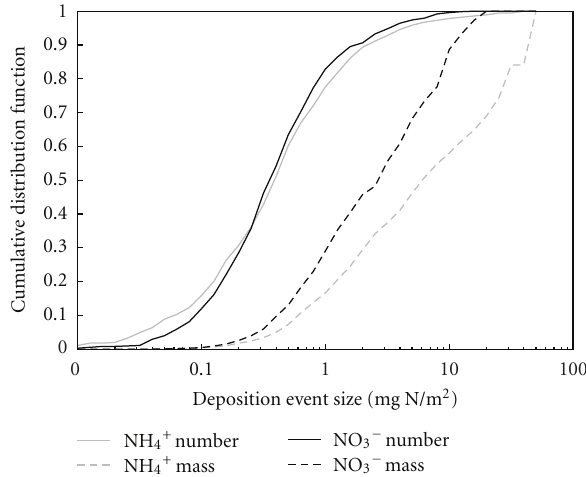
Figure 4: Cumulative distribution function of number and mass distributions for nitrate and ammonium. Table 1: Mean annual number fraction of samples that deliver less or equal mass to the threshold level, and mass fraction of deposited nitrogen through these samples. The precipitation year as defined in the Section 2 was used for the calculations of the annual mean.